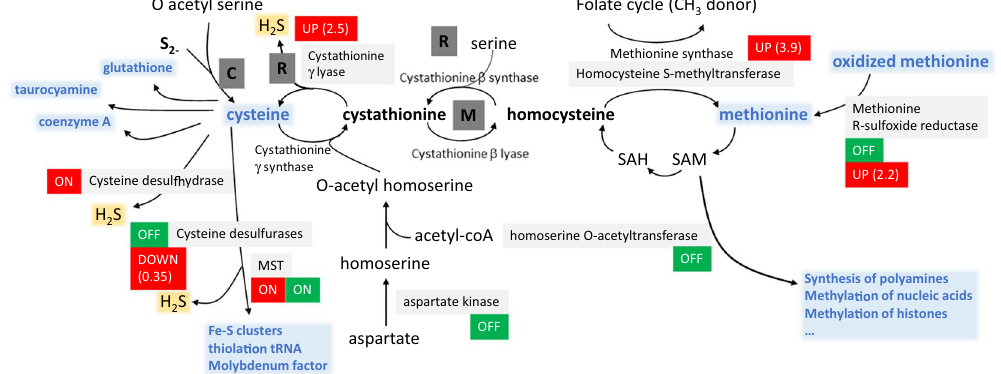
Figure 8. Theoretical schematic view of the synthesis of methionine and cysteine in Phytophthora and effects of DMTS (red) and MMTS (green). In plants, sulfide is incorporated by the cysteine synthase into O-acetylserine to produce cysteine ( C = cysteine pathway). In fungi, the main pathway involves the synthesis of cystathionine from O-acetylhomoserine as substrate for the homoserine O-acetyltransferase. From cystathionine, the activity of the cystathionine γ lyase in the reverse trans-sulfuration pathway ( R ) results in cysteine production. The methionine synthesis pathway ( M ) involves the γ cystathionine synthase and the cystathionine β lyase, which synthetize homocysteine, the precursor for methionine. Methionine can be synthetized from homocysteine by the methionine synthase using folate as methyl donor or by the homocysteine S-methyltransferase using homocysteine and S-adenosyl methionine (SAM). All reactions depicted in this schema are controlled by enzymes annotated in the KEGG for P. infestans . The thiosulfate pathway does not seem to exist in Phytophthora . Also highlighted is the significance of cysteine as substrate for cysteine desulfurases to produce important cofactors (molybdenum cofactor, Fe-S clusters) and to thiolate tRNA (MST = mercaptopyruvate sulfurtransferase). Glutathione, coenzyme A, taurocyamine are also important sulfur compound produced from cysteine in Phytophthora . Methionine, besides being an important amino acid for proteins, is metabolized to S-adenosyl methionine (SAM), which participates in the methylation of nucleic acids or histones, or the synthesis of polyamines. Modifications in protein amounts observed upon sVOC treatments are shown in red (DMTS) and green